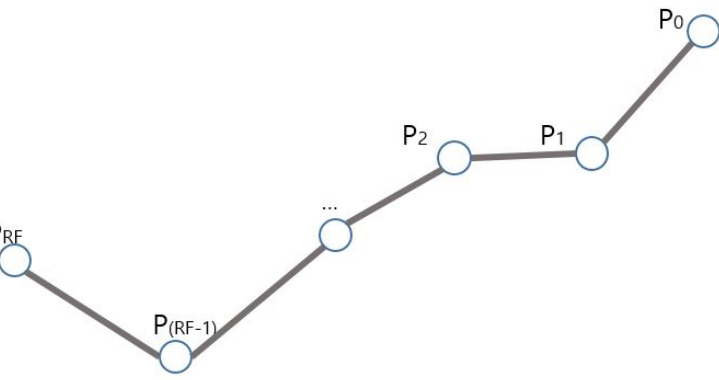
Figure 5. Locus of left elbow point (which is represented as a circle). Locus shows as much as before RecentFrame (RF) from the Current Frame. RecentFrame is the frame depth variable, which is 5 in the current figure.